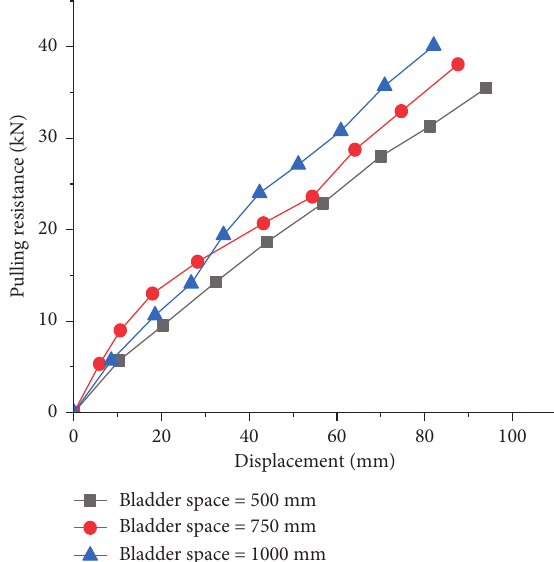
Figure 9: The pulling force vs. displacement relationship under different bladder space